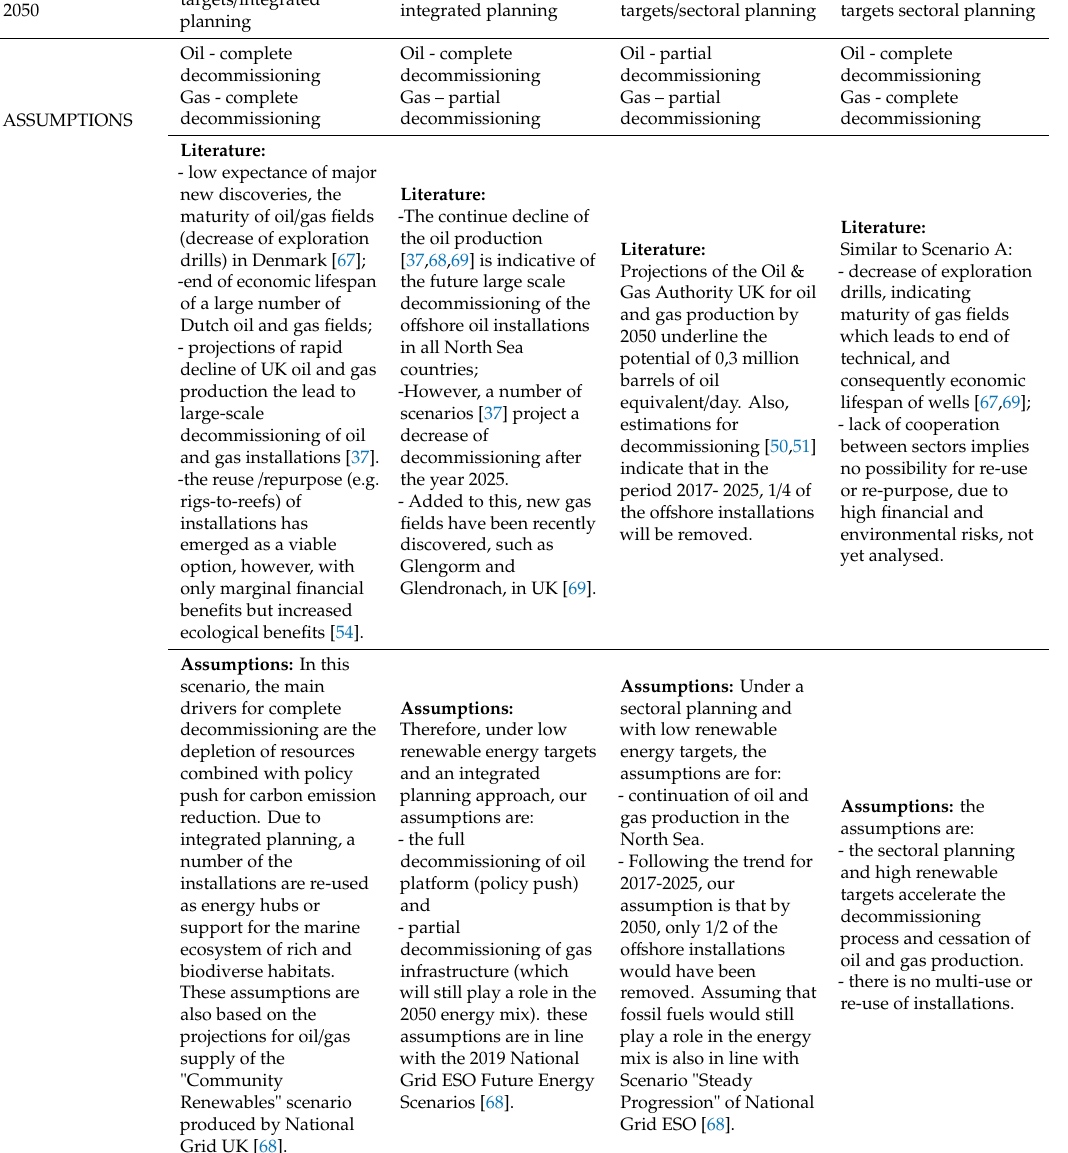
Table A4. Assumptions for the decommissioning and removal of oil and gas infrastructure. SCENARIOS